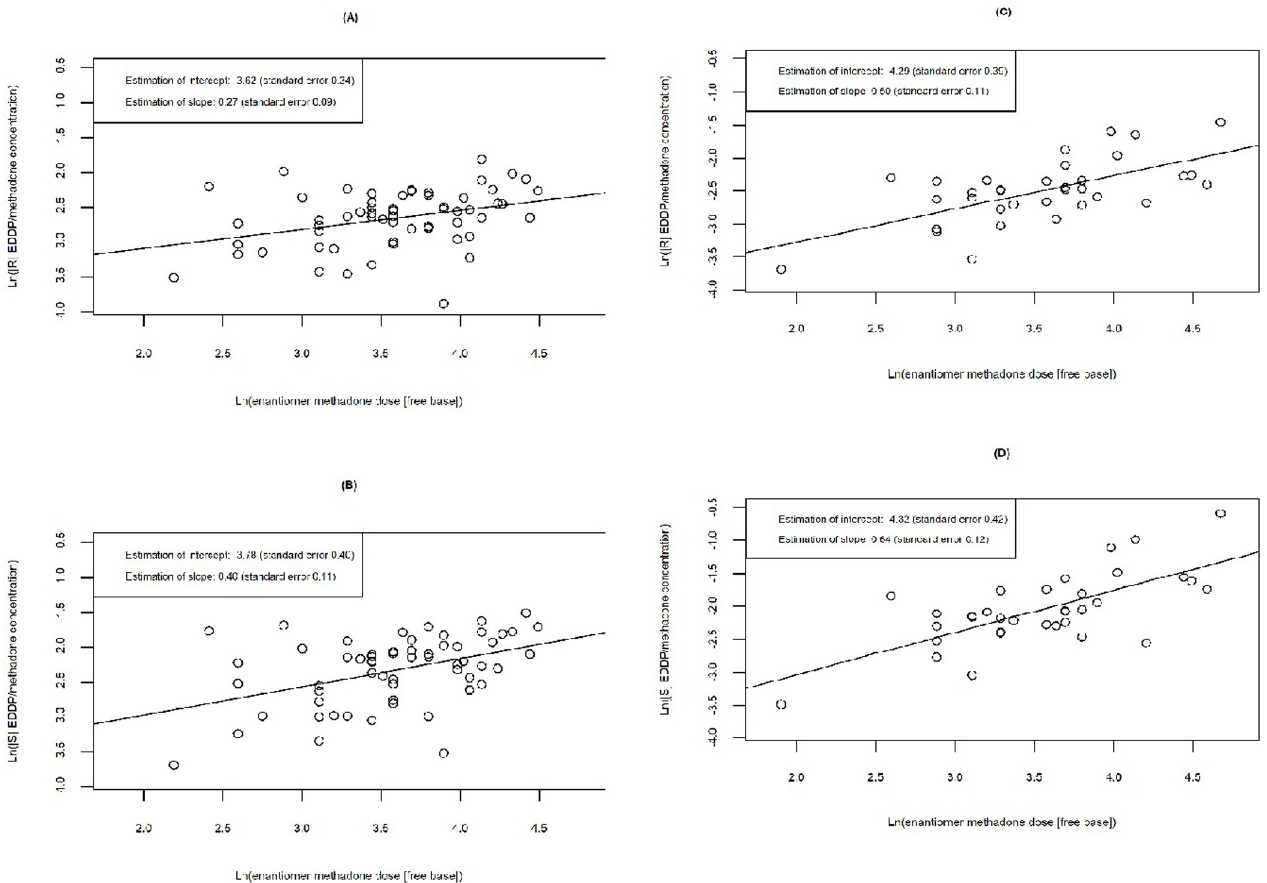
Fig 4. Linear relationship between ln(methadone metabolism) and ln(methadone dose) by enantiomer and CYP2B6 genotype function. In both LOF and normal function participants, (R)- and (S)-EDDP/methadone concentration increases by 2.71 mg per increase in enantiomer methadone dose [i.e., one unit increase in ln(enantiomer methadone dose)]. In LOF participants, (A) average (R)-EDDP/methadone concentration increases by 1.31 [ln(R-EDDP/methadone concentration) increases by 0.27, standard error 0.09], and (B) average (S)-EDDP/methadone concentration increases by 1.49 [ln(S-EDDP/methadone concentration) increases by 0.40, standard error 0.11]. In normal function participants, (C) average (R)-EDDP/methadone concentration increases by 1.65 [ln (R-EDDP/methadone concentration) increases by 0.50, standard error 0.11], and (D) average (S)-EDDP/methadone concentration increases by 1.90 [ln (S-EDDP/methadone concentration) increases by 0.64, standard error